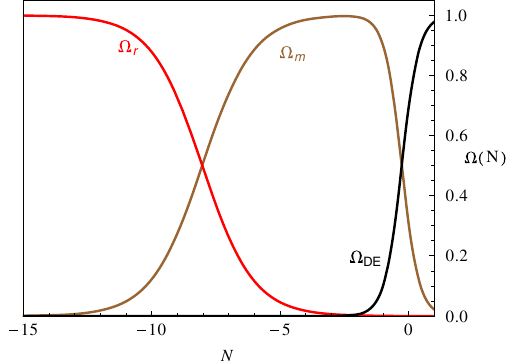
Fig. 5 Plot of the density parameters in the Universe with the number of e-foldings N given by N = − ln ( 1 + z ) where z is the corresponding redshift